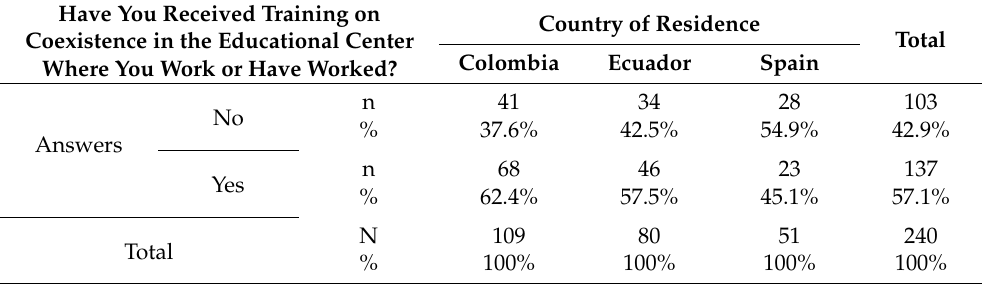
Table 2. Cross-categorization of the variable “Have you received training in Coexistence in the educational center where you work?” and the variable “Country of Residence”.